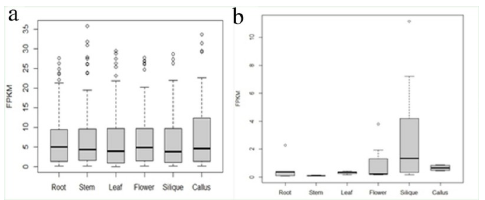
Fig 4. Comparisons of expression level of positively selected genes with constitutive expression (a) and positively selected genes with tissue specificity (b) in six B . rapa tissues (roots, stems, leaves, flowers, siliques and callus).